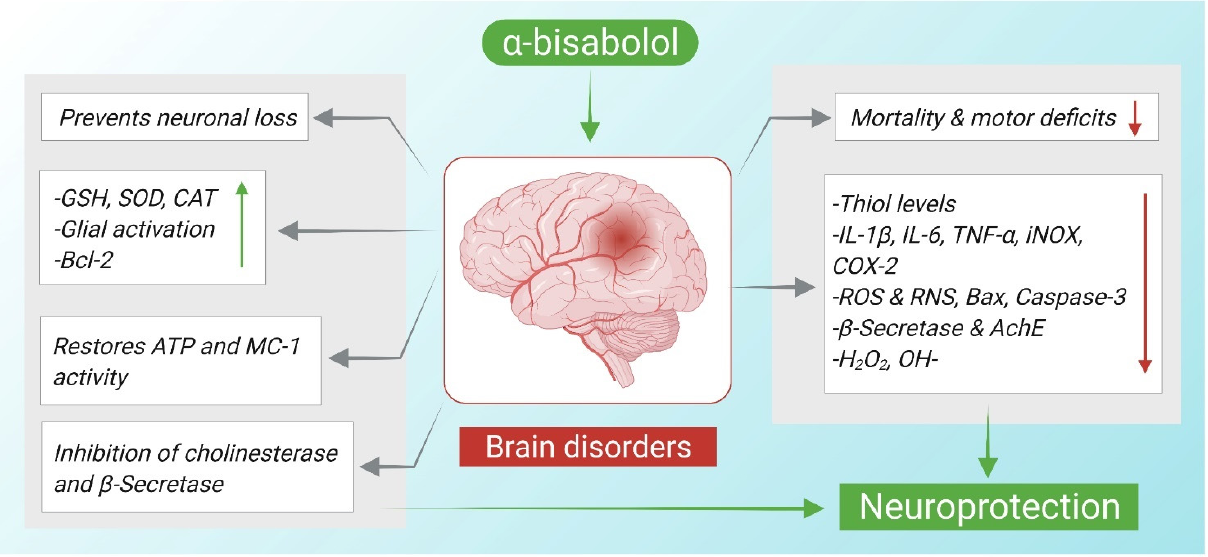
Figure 2. Neuroprotective mechanisms of α -Bisabolol against neurodegeneration. ↑ ; increase, ↓ ;